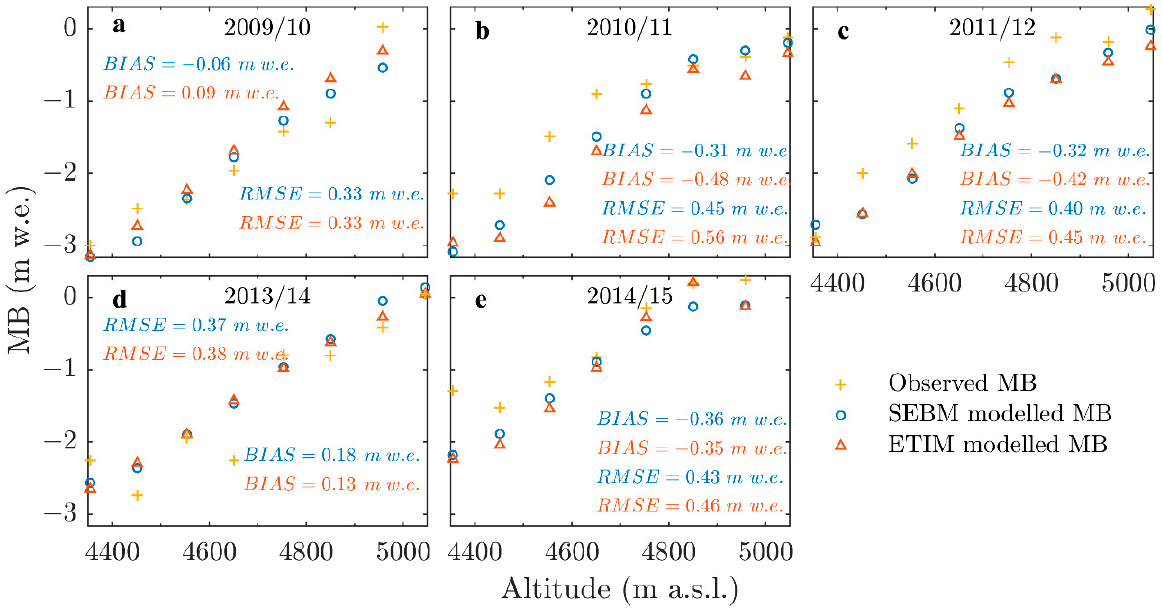
Figure 4. Observed and modeled mass balance (MB) at different altitudes from 2009/10 to 2014/15 (a-e, excluding 2012/13). Blue and red symbols represent SEBM and ETIM, respectively.